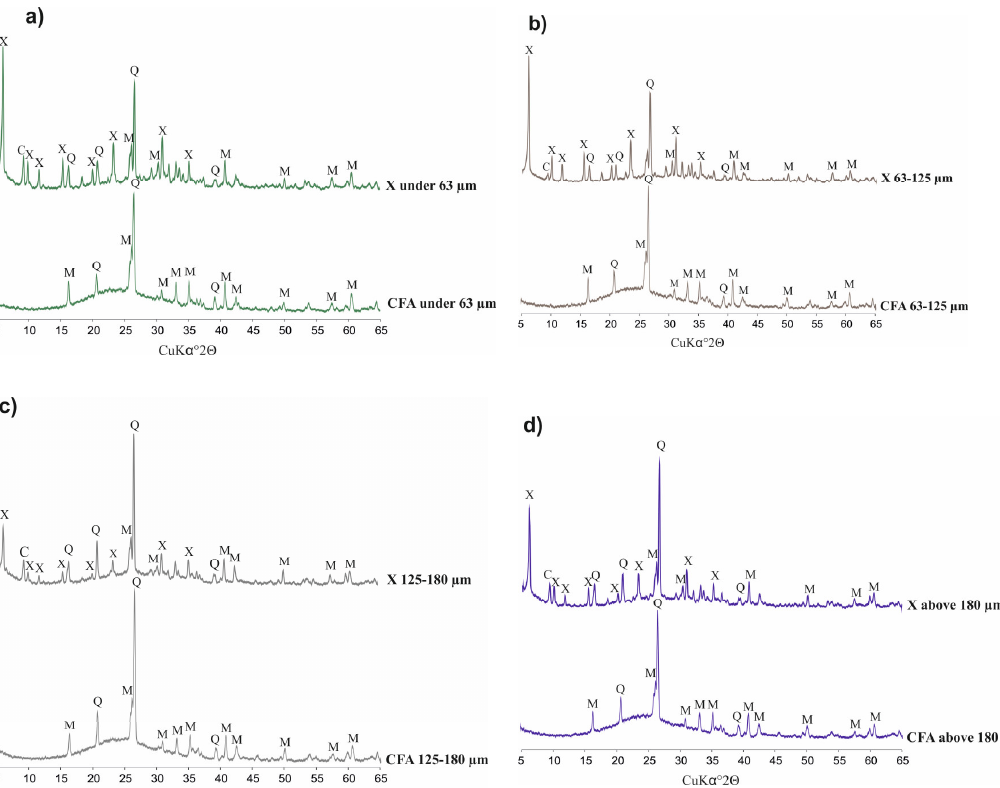
Figure 4. Phase analysis of CFA (coal fly ash) samples, after sieving, and zeolites obtained from them.( a ) CFA fraction under 63 µm and X type zeolite from it; ( b ) CFA fraction from 63 µm to 125 µm and X type zeolite from it; ( c ) CFA fraction from 125 µm to 180 µm and X type zeolite from it; ( d ) CFA fraction above 180 µm and X type zeolite from it .